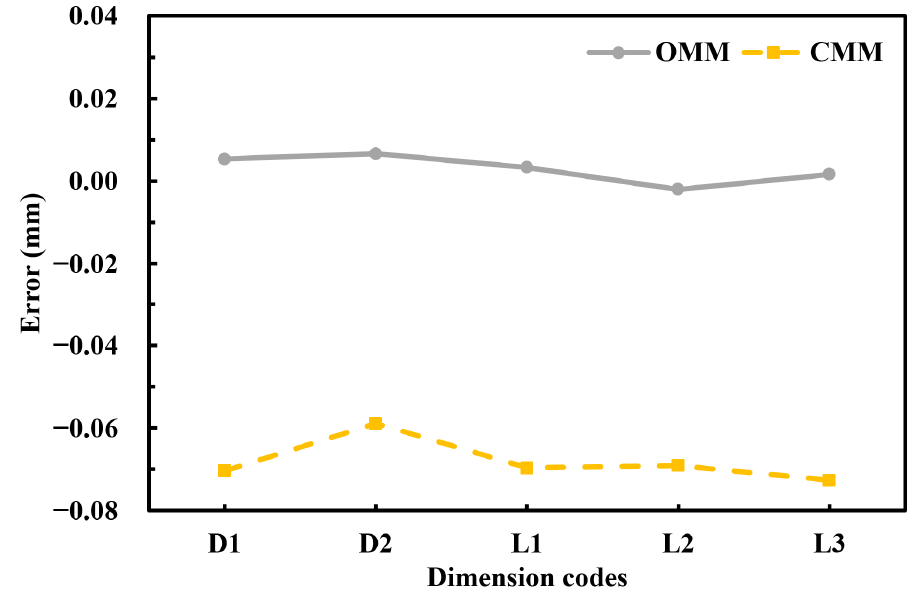
Figure 8. Comparison chart of measurement between OMM (before probe calibration) and CMM.